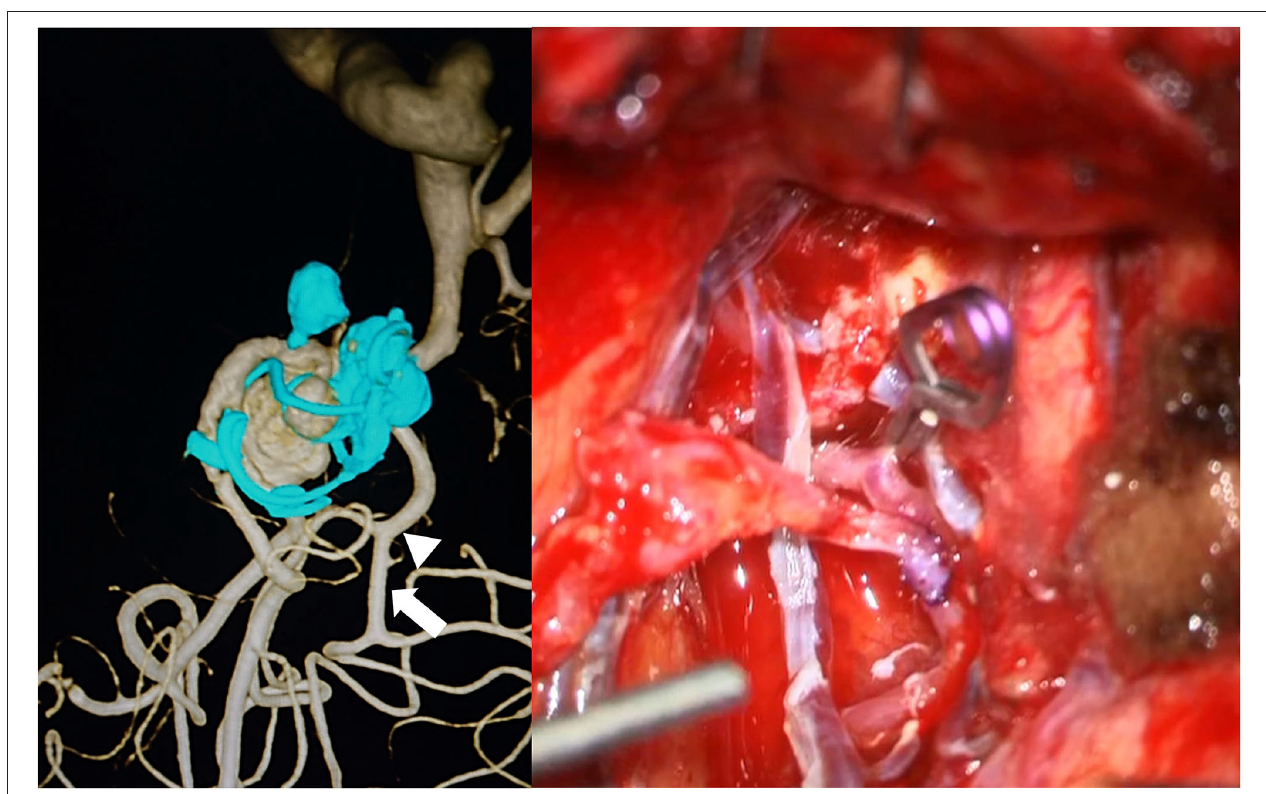
FIGURE 2 | Left: Preoperative three-dimensional rotational angiography, describing the aneurysm estimated for an operative view. The arrow indicates the bypass site, and the arrowhead indicates the ligation point. Right: A frontal branch of the superficial temporal artery and M2 bypass followed by ligation of M2 proximal to bypass.